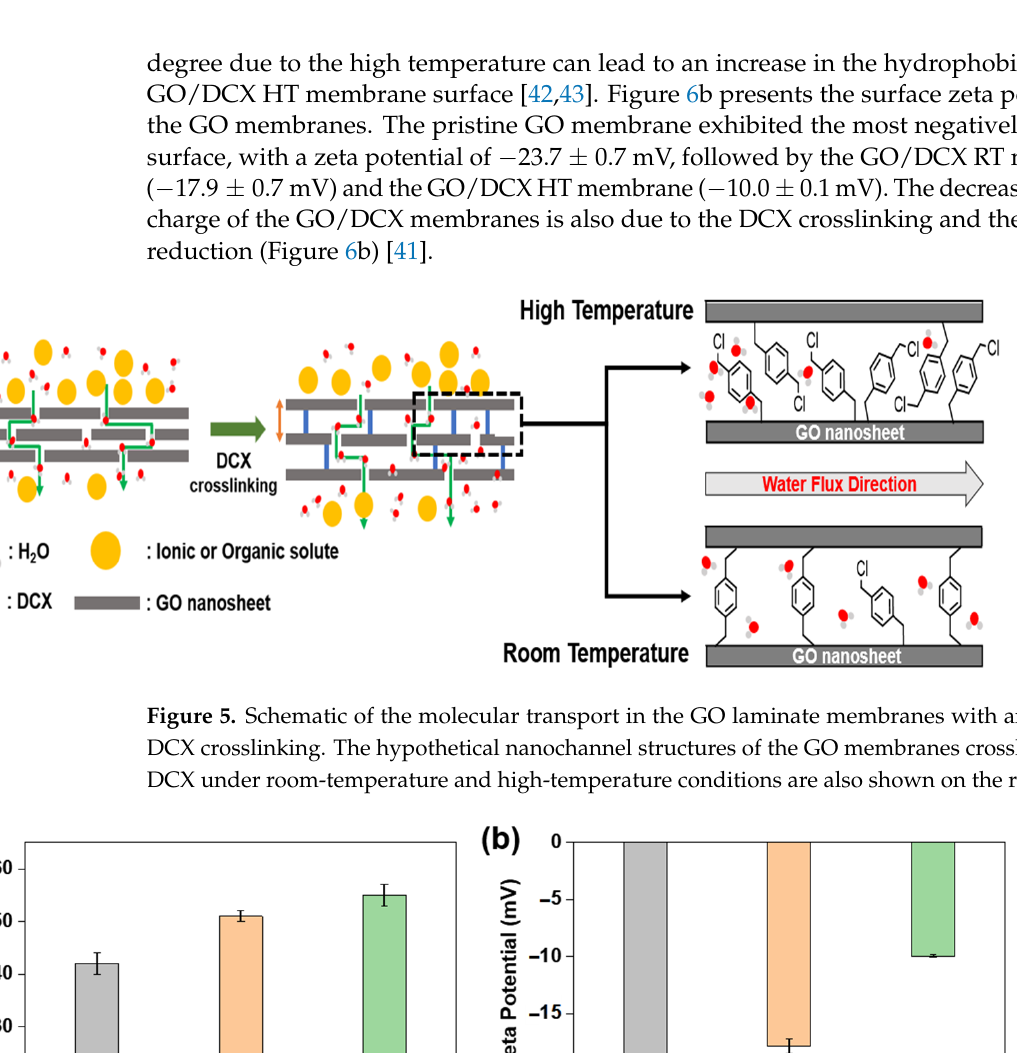
Figure 5. Schematic of the molecular transport in the GO laminate membranes with and without DCX crosslinking. The hypothetical nanochannel structures of the GO membranes crosslinked with DCX under room-temperature and high-temperature conditions are also shown on the right.